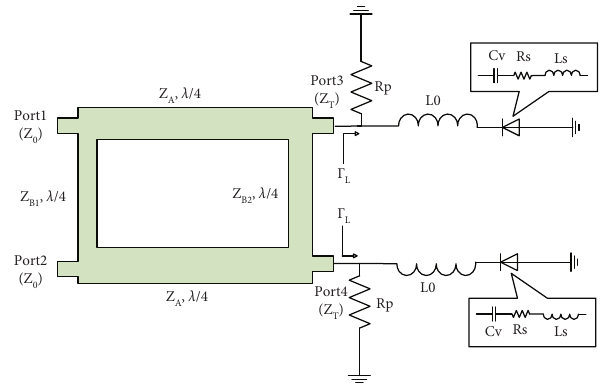
Figure 2: Construction of the reflective phase shifter.